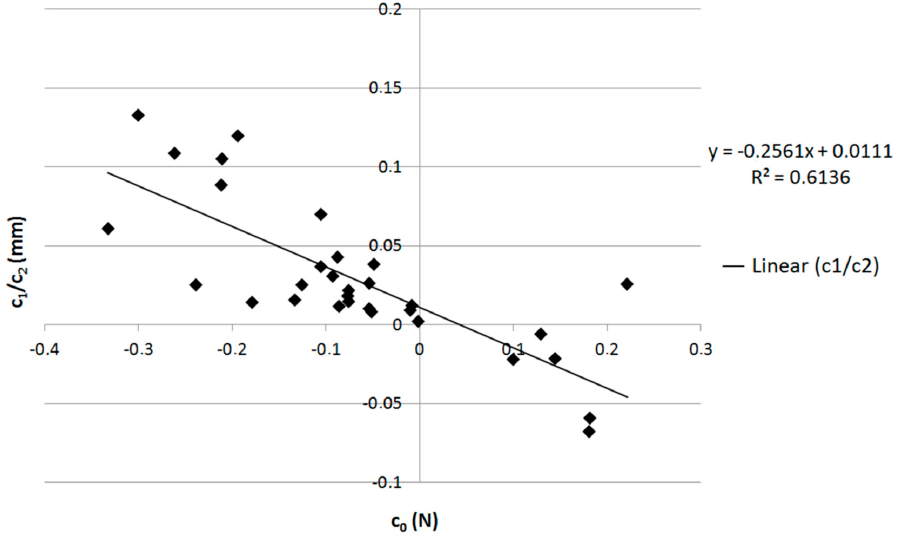
Figure 1. The relationship between c 0 and c 1 /c 2 .